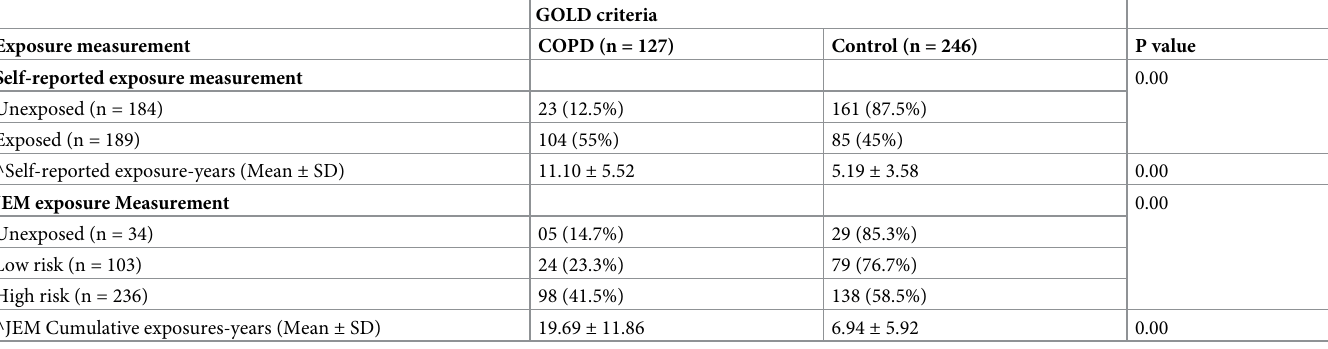
Table 3. Occupational exposures among the COPD and control group.